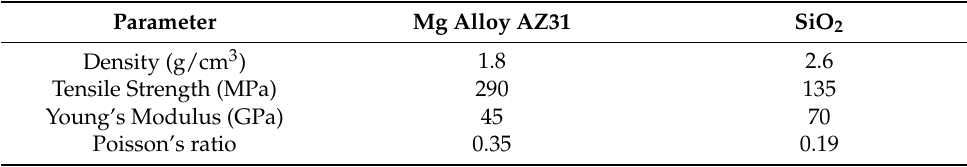
Table 2. Mechanical properties of matrix and reinforcement